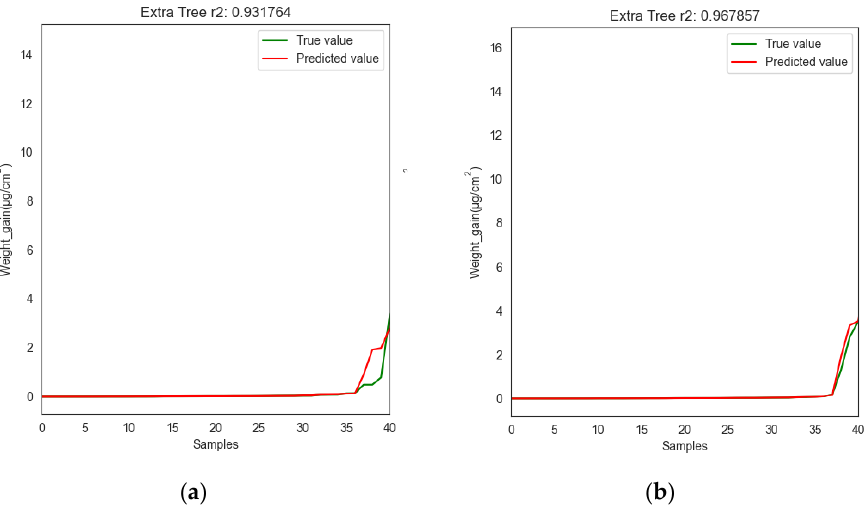
Figure 6. Predictive performance of the models ( a ) with and ( b ) without feature selection. Table 2. RMSE and R 2 values for corrosion weight gain prediction models with and without feature selection.